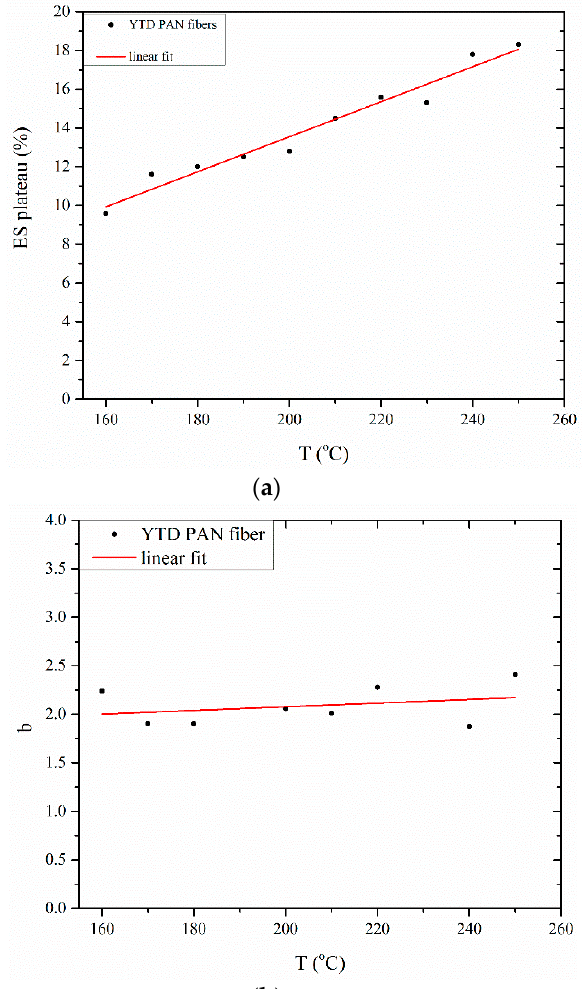
Figure 5. ( a ) Entropic shrinkage (ES) plateau parameter and ( b ) exponent b of Equation (1) in relation with stabilization temperature.